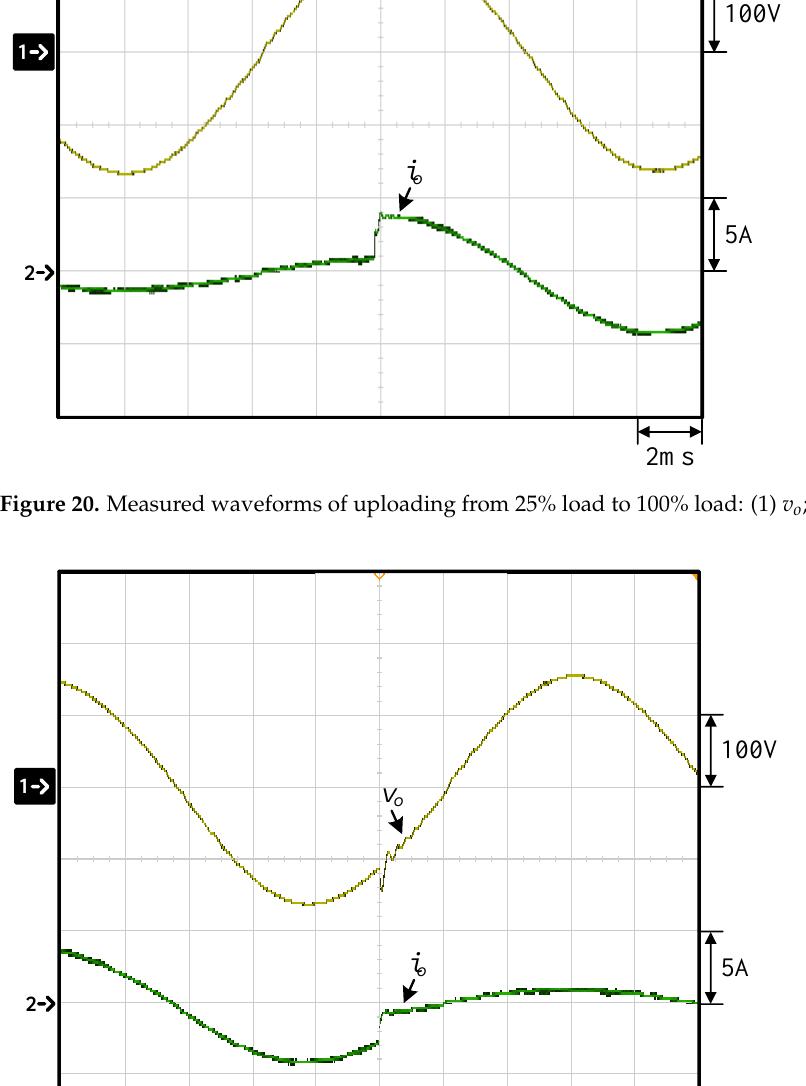
Figure 21. Measured waveform of downloading from 100% load to 25% load: (1) v o ; (2) i o .